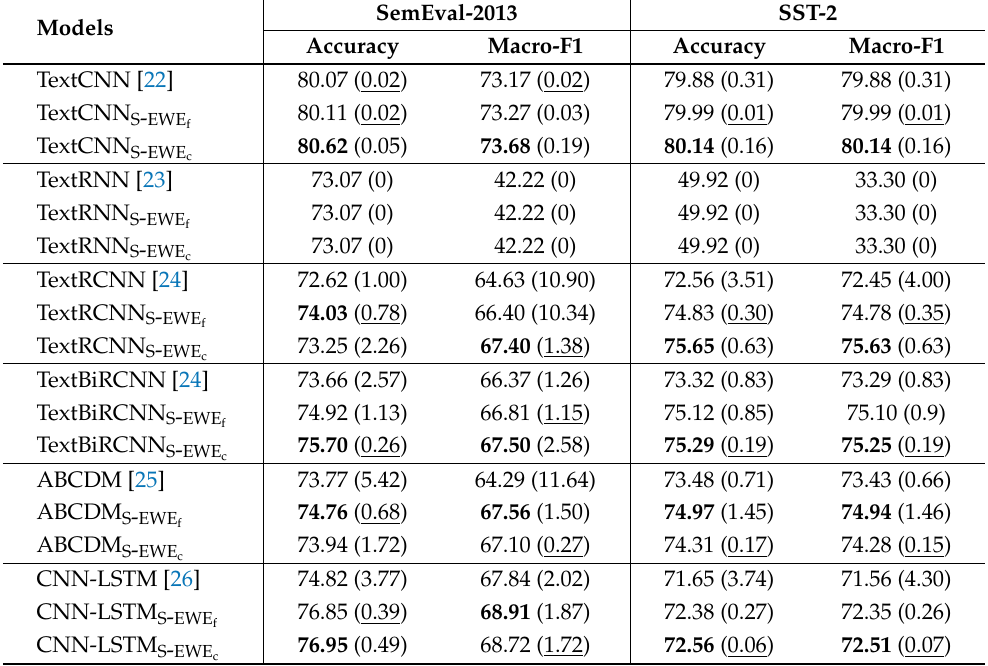
Table 6. The accuracies and macro-F1 scores of different models using GloVe with/without S-EWE c and S-EWE f on SemEval-2013 and SST-2 datasets (%). The accuracies and macro-F1 values were obtained in the same way as those in Table 5. Moreover, the values in parentheses, bold text, and underlined text represent the common meanings in Table